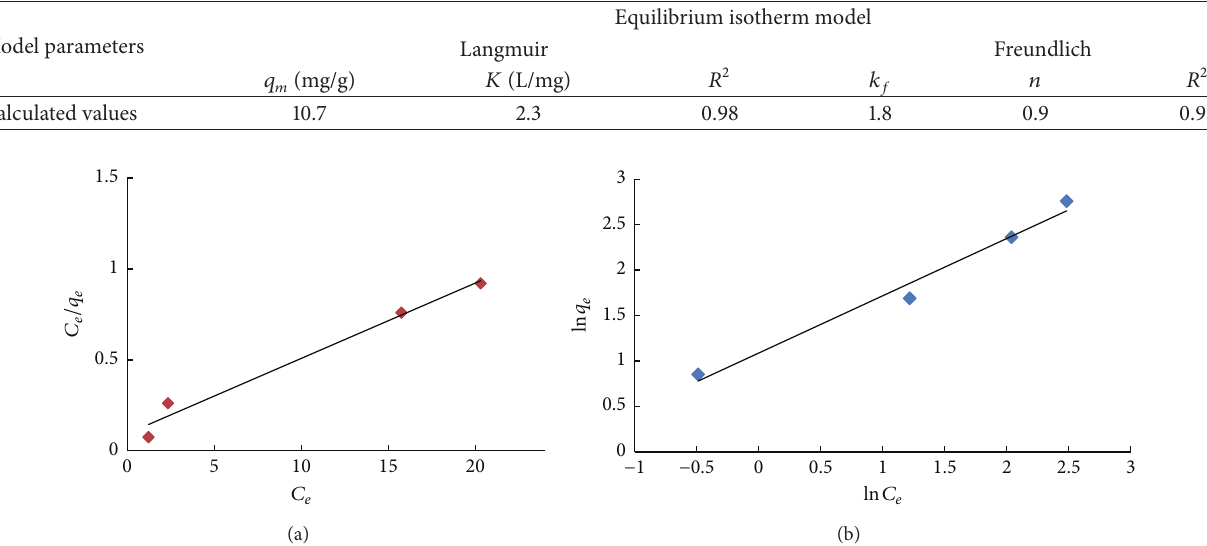
Table 2: Estimated parameters of equilibrium isotherm models of basic violet 16 sorption onto composite sheet matrix.